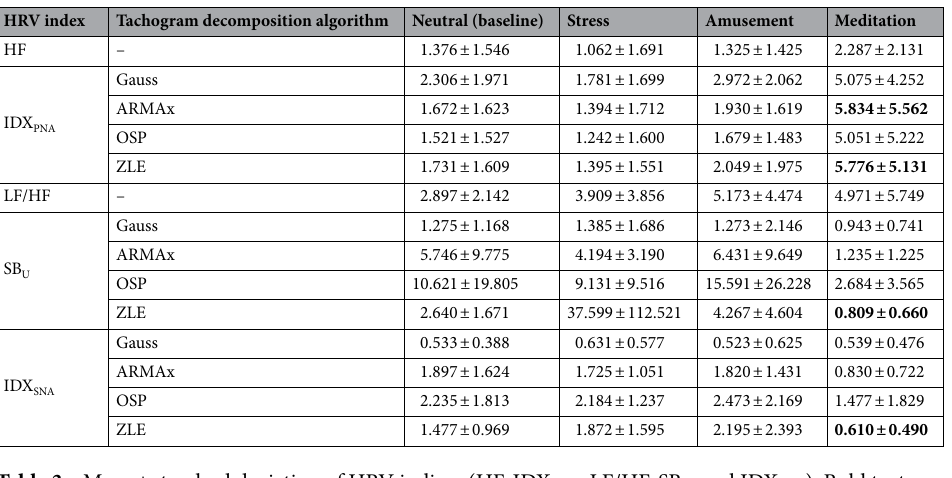
Table 3. Mean ± standard deviation of HRV indices (HF, IDX PNA , LF/HF, SB U , and IDX SNA ). Bold text represents a statistically significant difference between neutral and other affective states (p < 0.000005). HF and IDX PNA are the HRV indices related to vagal tone, and other indices (LF/HF, SB U and IDX SNA ) indicate sympathetic tone. In meditation state, IDX PNA s of ARMAx and ZLE showed significant increases, and statistically significant decreases were observed in SB U s and IDX SNA s of